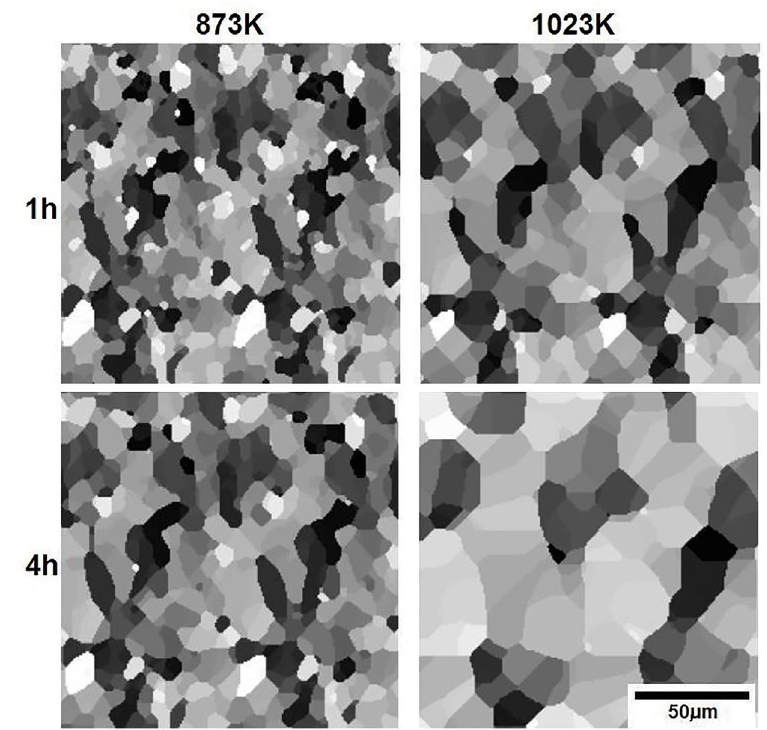
Figure 6: Evolution of grain structure simulated at temperatures of 873 K and 1023 K after 60 and 240 minutes.